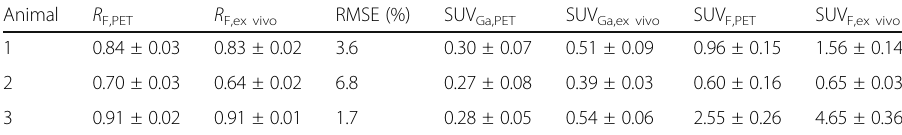
Table 1 R F,PET and R F,ex vivo values are represented as the mean ± SD of all the myocardial segments analyzed for each animal along with their comparison obtained using the RMSE value. Mean ± SD SUV for each tracer obtained from multi-tracer PET analysis and excised tissue are also shown Animal R F,PET R F,ex vivo RMSE (%) SUV Ga,PET SUV Ga,ex vivo SUV F,PET SUV F,ex vivo 1 0.84 ± 0.03